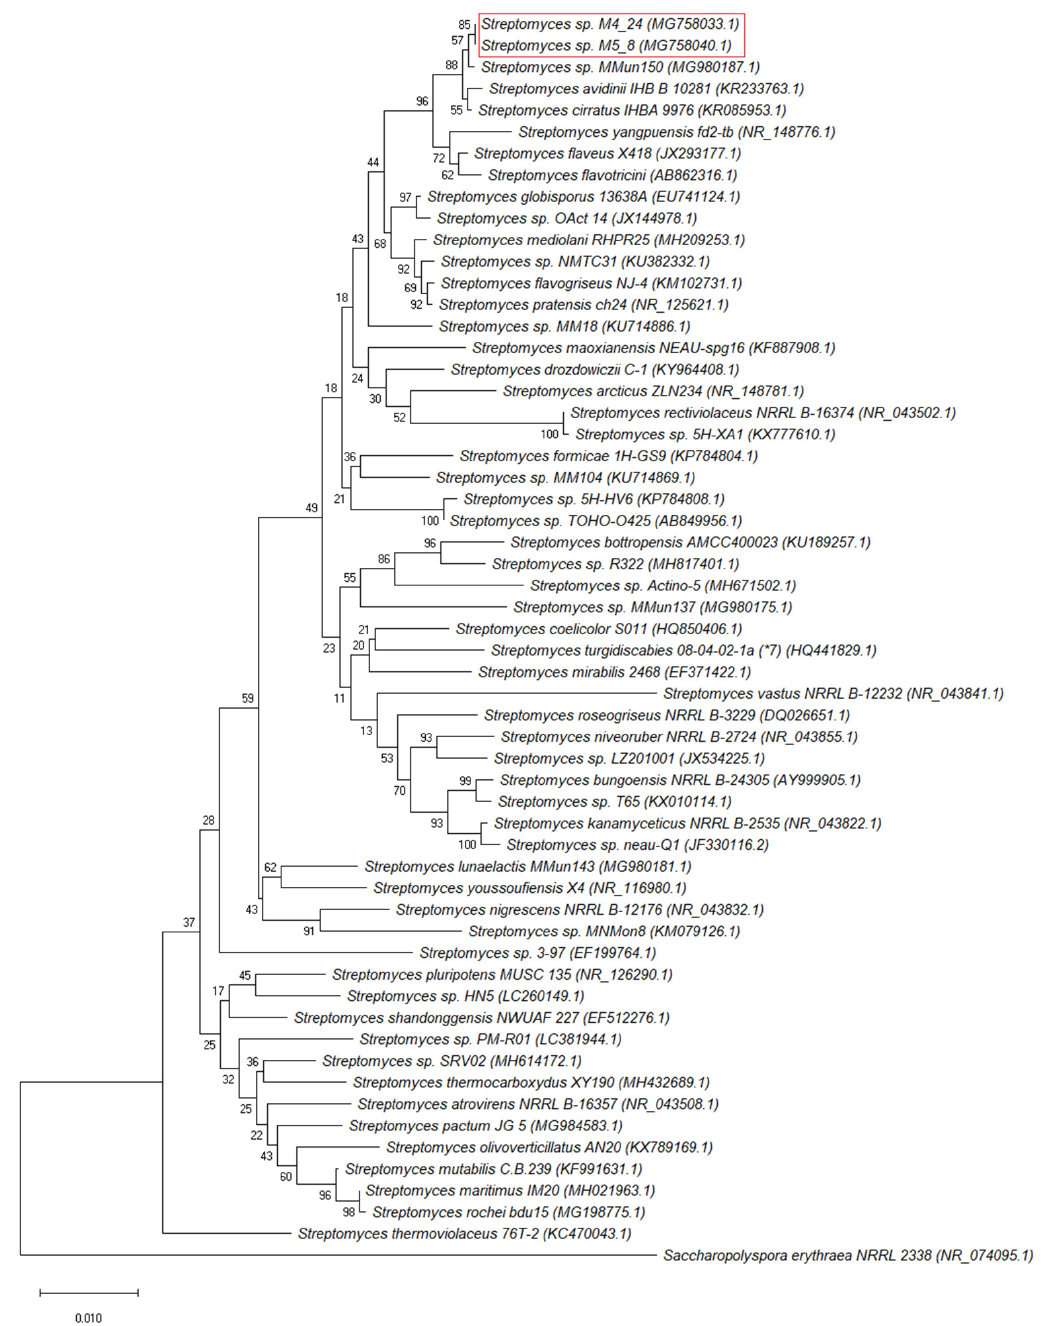
Figure 3. Phylogenetic analysis of Streptomyces M4_24 and M5_8 strains. The alignment and a Neighbor-Joining (NJ) tree, based on Jukes–Cantor Genetic Distance Model, was constructed using the MEGA X software, with Saccharopolyspora erythrea NRRL 2338 as an outgroup. Bootstrap values are shown from 1000 replicates.